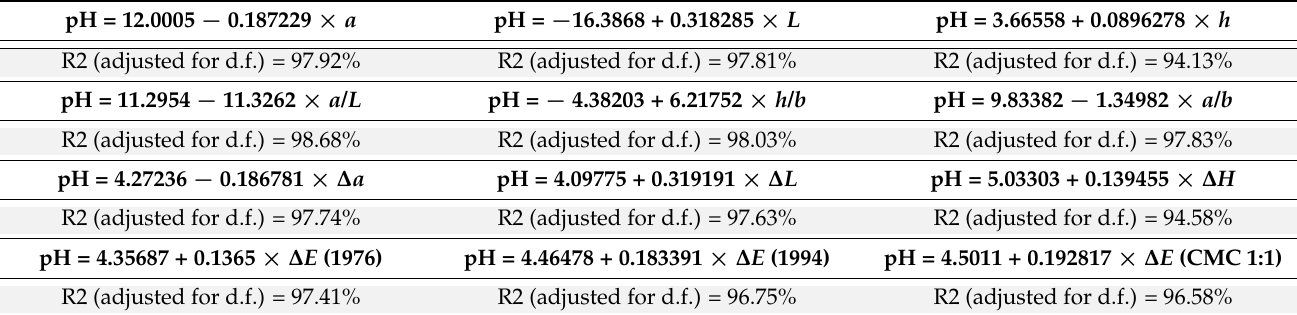
measured data—colorimetric parameters L, a, b, C, h , their ratios and differences, and the